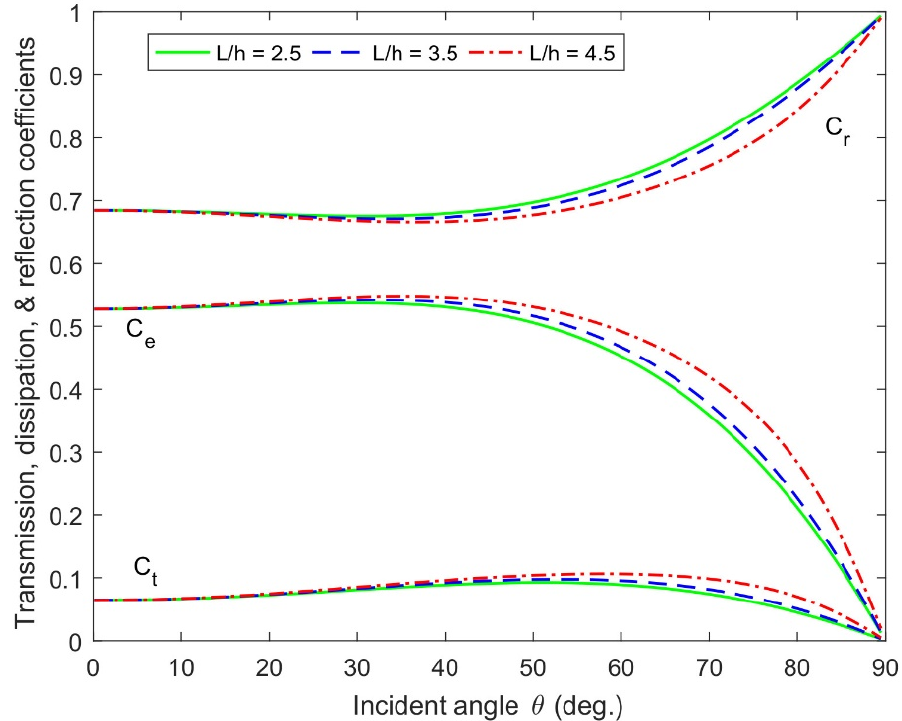
C , C , and C versus θ with 1.0 0.5 i σ = + . r t e